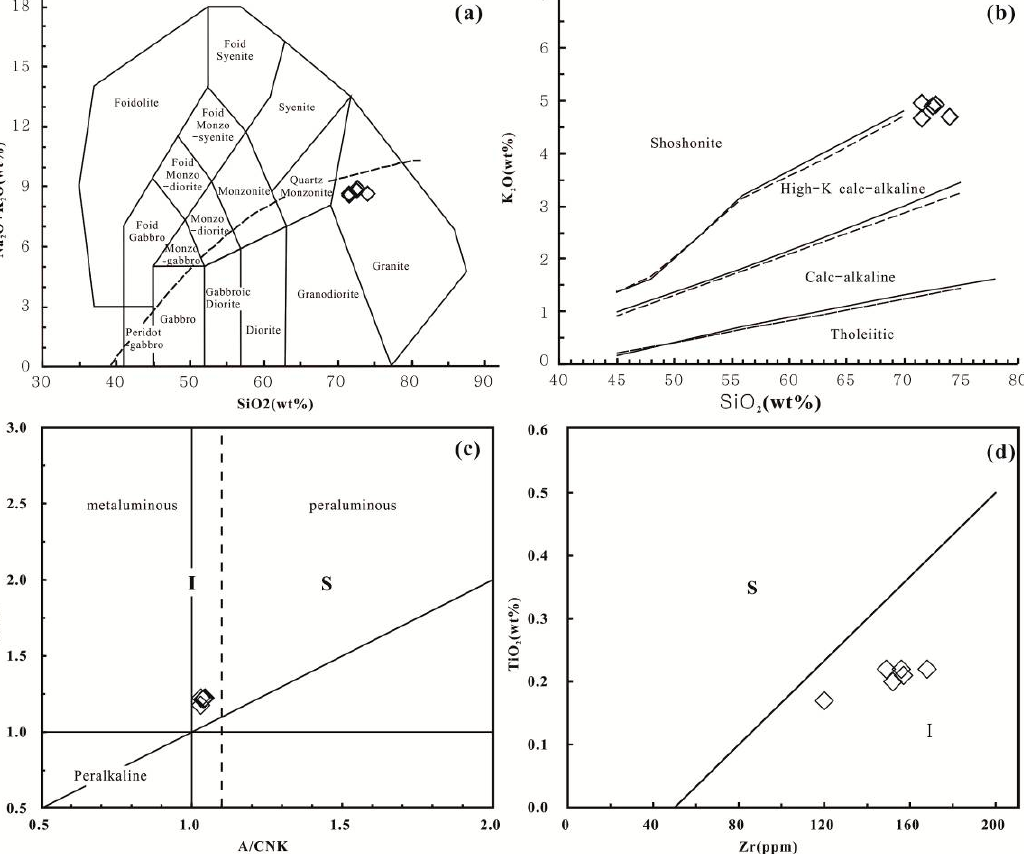
Figure 5. TAS ( a after [18]), K 2 O vs. SiO 2 diagram ( b after [19]), Al 2 O 3 / (CaO + Na 2 O + K 2 O) vs. Al 2 O 3 / (Na 2 O + K 2 O)diagram ( c after [20]) and TiO 2 vs. Zr diagram ( d ) for the MG from the Wulandele Mo deposit. S, S-type granite; I, I-type granite.